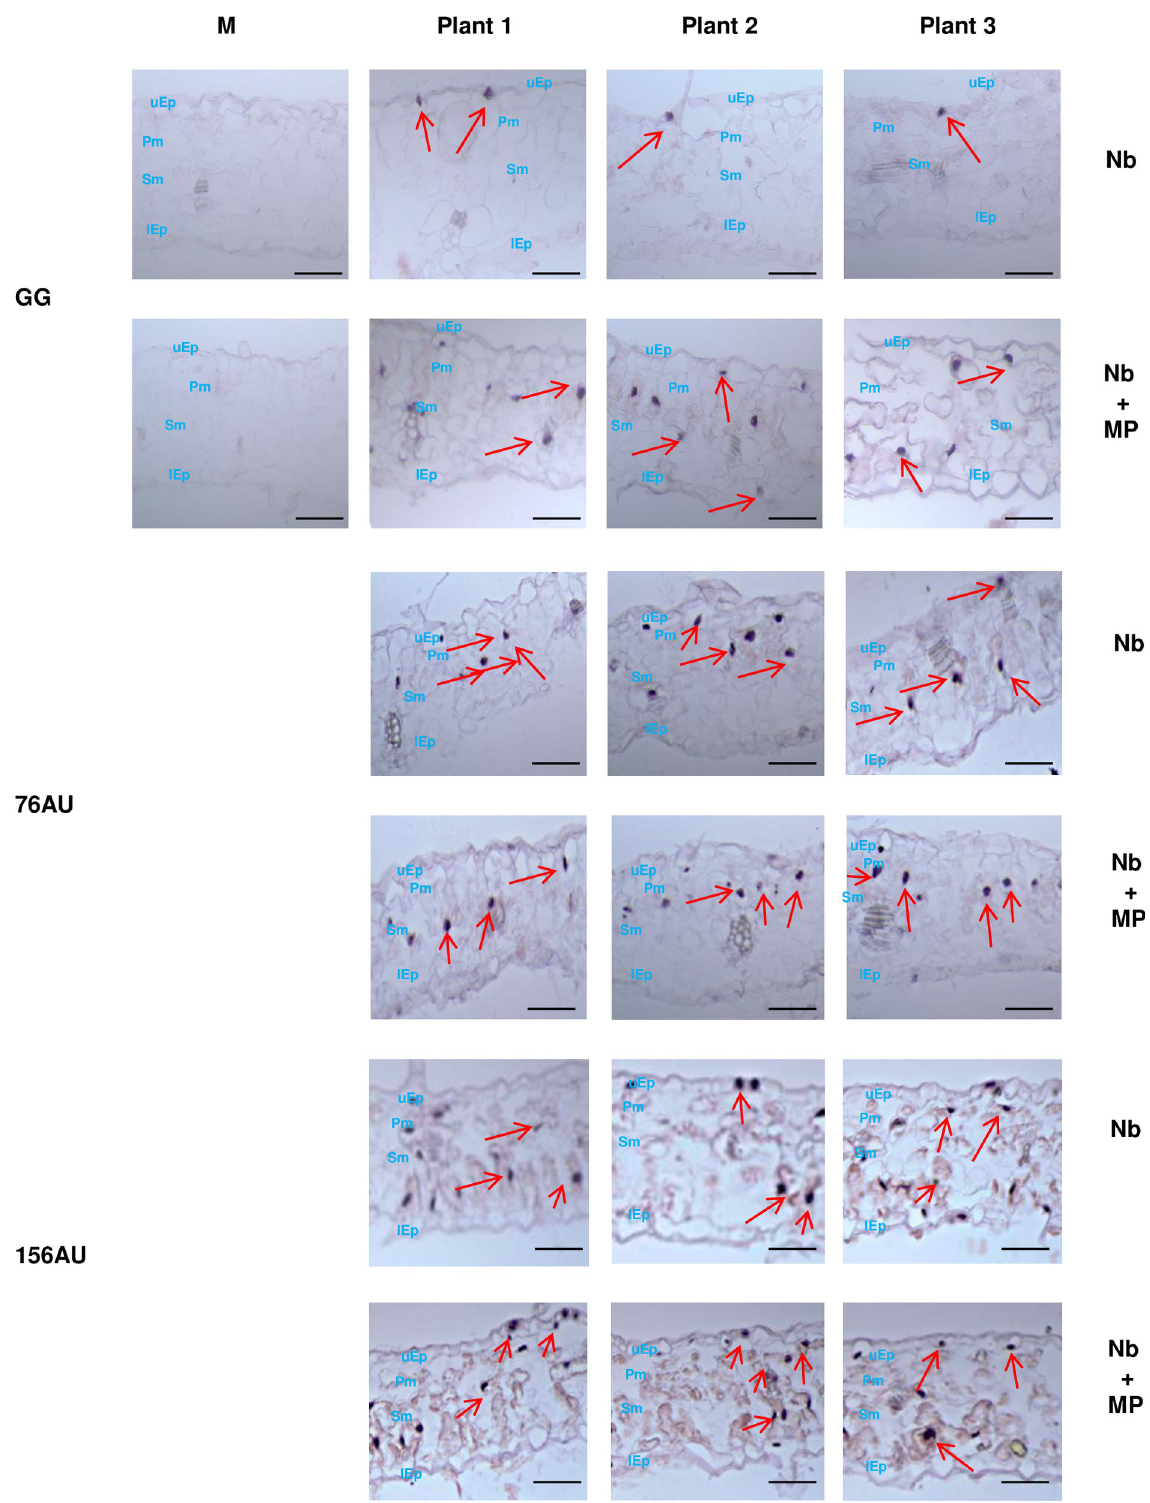
Fig 3. TMV MP enables mesophyll entry of the GG mutant but does not affect the cellular distribution of 76AU and 156AU mutants in inoculated leaves. Transverse section in situ hybridization was conducted to analyze the accumulation of the GG, 76AU, and 156AU mutants in different cell types. Rub-inoculated leaves from three Nb and three Nb+MP plants infected with GG, 76AU, or 156AU were collected at 10